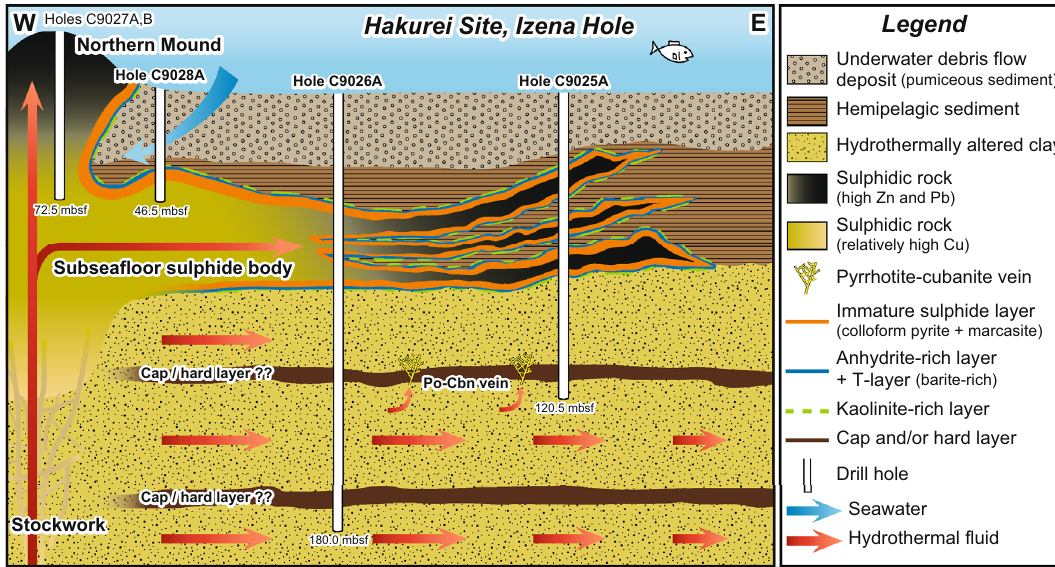
Figure 4. Simplified subseafloor structure of the Hakurei Site, Izena Hole. The subseafloor sulphide body underlies the pumiceous underwater debris flow deposit within hemipelagic sediment and contains at least two hemipelagic sediment layers. The footwall of the sulphide body consists of hydrothermally altered clay with alteration minerals dominated by chlorite + illite ± K-feldspar. A layer of hydrothermally altered clay 10–15 m below the sulphide body contains pyrrhotite-cubanite veins. A deeper cap layer in Hole C9026A appears to confine hot (> 200 °C) hydrothermal fluid. Not to scale. See Supplementary Fig. S11 for more details. Cbn cubanite, Po